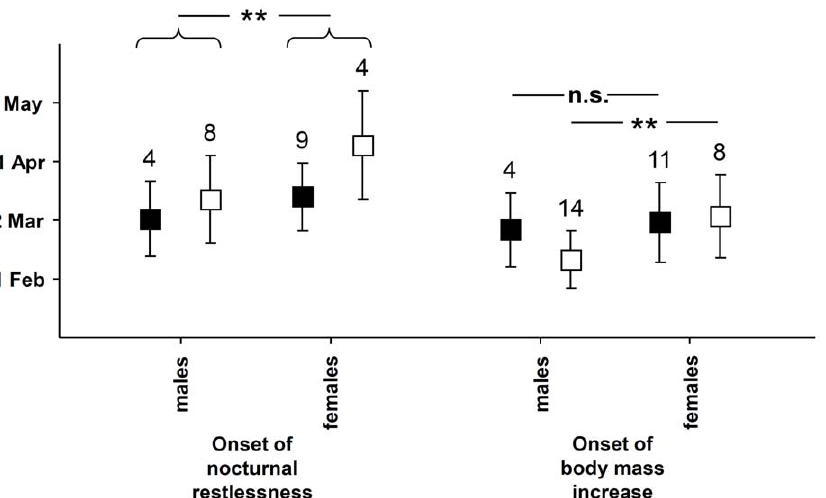
Figure 1. Mean ( ± s.d.) dates of onset of nocturnal restlessness and of body mass increase in male and female northern wheatears in spring. Black squares: Icelandic population, white squares: Norwegian population. The numbers above each boxplot indicate the sample sizes. Stars indicate P -level: ** P , 0.01. For better understanding, we assigned Day 1 of our count (starting on the day of photoperiodic switch) to a standardized date which was defined as the mean date of photoperiodic switch in the two years of experiment. For our data, this date was 26 August.